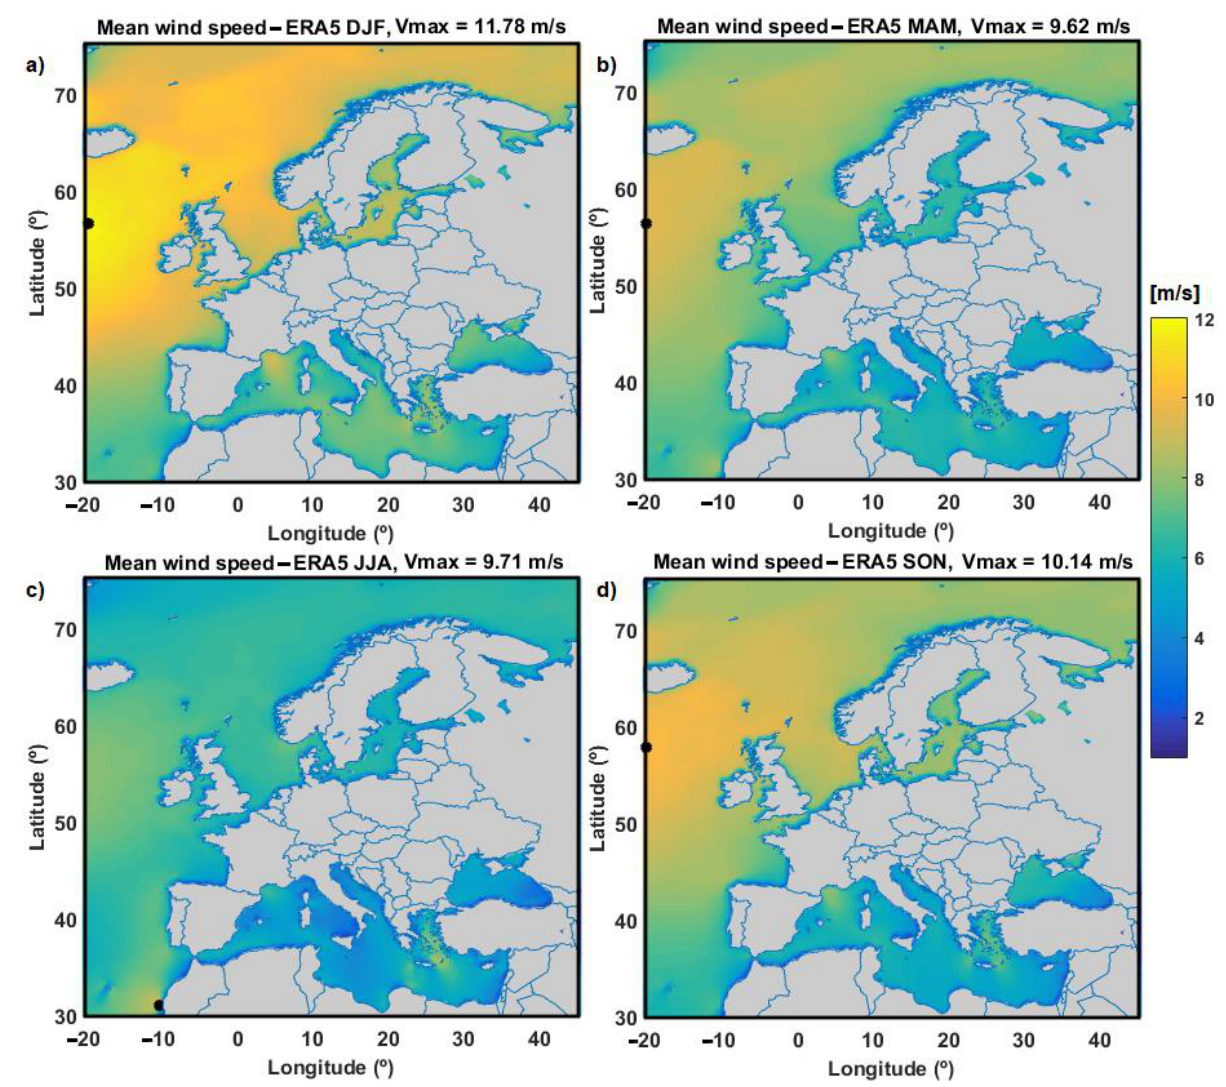
Figure 11. Seasonal variability of the mean wind speed over the 20-year time interval (from 2001 to 2020) based on ERA5 data: ( a ) winter (DJF), ( b ) spring (MAM), ( c ) summer (JJA), ( d ) autumn (SON).